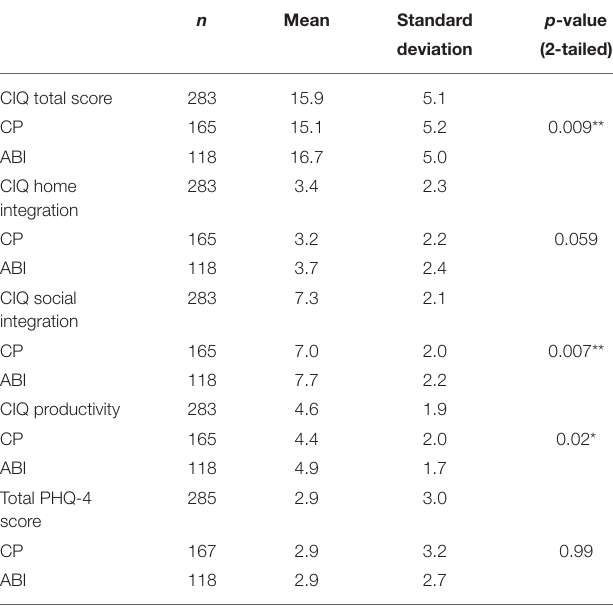
TABLE 4.1 | Condition-specific differences in the CIQ and PHQ-4.